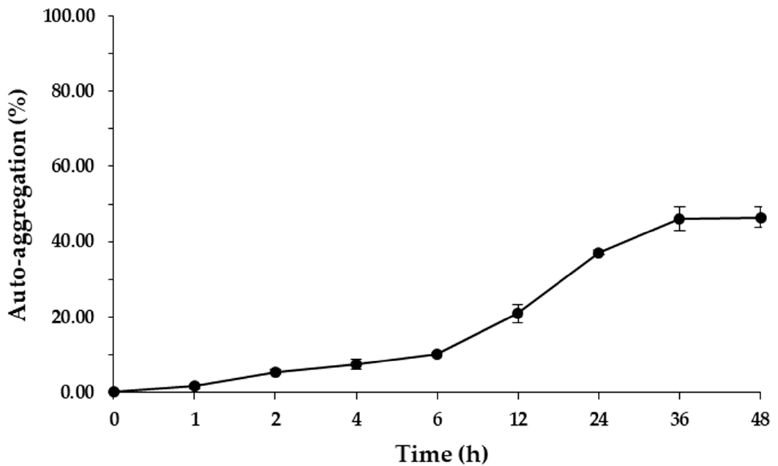
Figure 5. Percentage of auto aggregation ability of L. brevis F064A during 48 h of incubation. The results represented as mean ± S.D. ( n = 3).